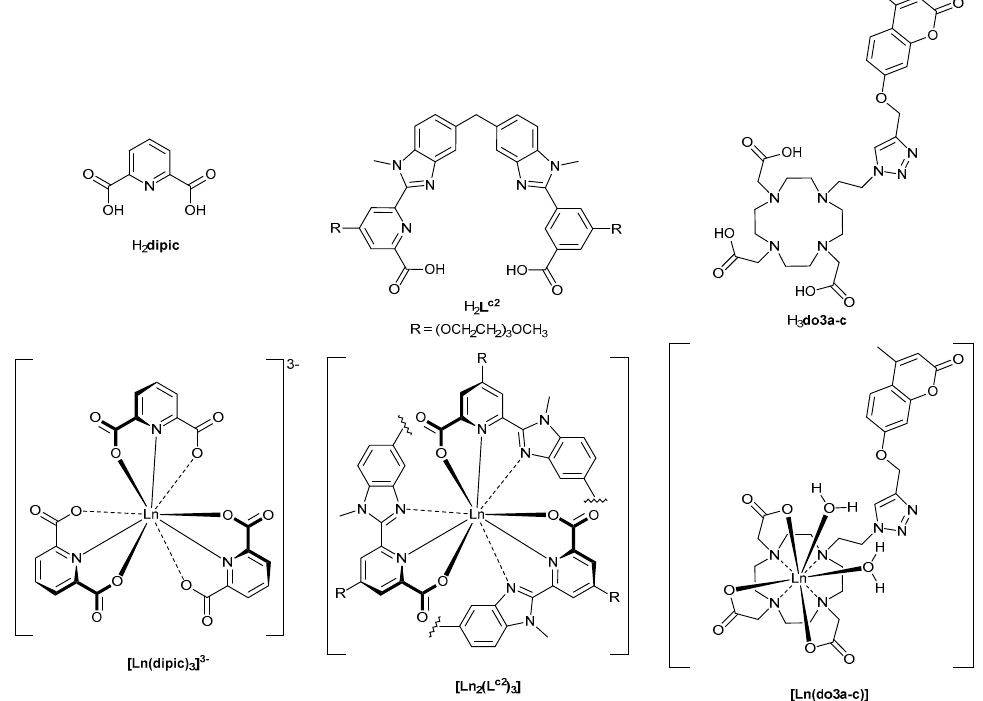
Scheme 1. Structure of dipicolinic acid (H 2 dipic ) of the helicate ligand (H 2 L c2 ) and of the do3a ligand (H 3 do3a-c ) forming 1:3, 2:3, and 1:1 (Ln/L) complexes with a D 3h , D 3 , and C 4v symmetry around the Ln ion, respectively ( ∆ enantiomer shown). Molecules 2020 , 25 , x FOR PEER REVIEW